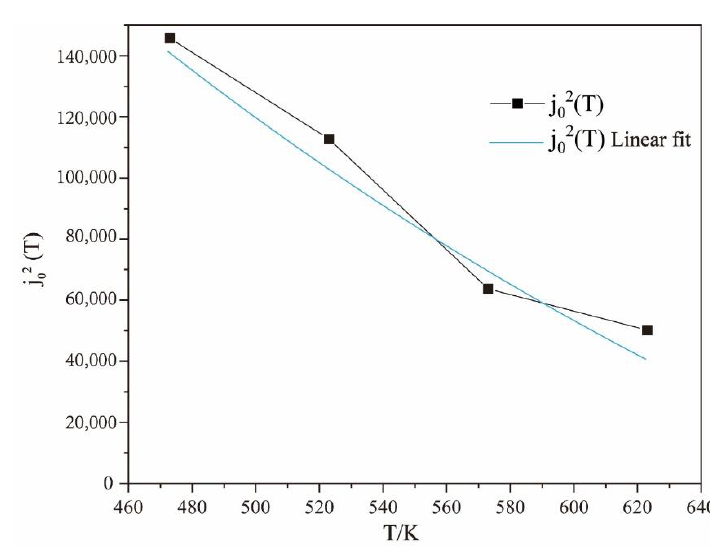
Figure 10. 𝑗 02 (𝑇) of the Mg 98.5 Zn 0.5 Y 1 alloy at different temperatures. Figure 10. j 2 ( T ) of the Mg 98.5 Zn 0.5 Y 1 alloy at different 0